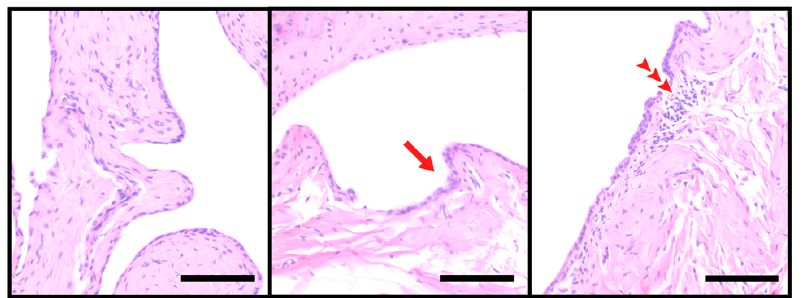
Figure 8. Representative images of synovitis in the PTOA group. Histological images of the synovitis, as demonstrated by surface fibrin and sub-synovial infiltration, found in the PTOA animals. Healthy synovium (first box) is presented as a comparison and represents Naive tissue. Surface fibrin (red arrow) and sub-synovial infiltration (red arrowheads) were found significantly more in the PTOA group compared to the Naive, but was not different between genetic variants. Images take at 20× magnification, scale bars represent 100 µm (N = 15 rats/PTOA group and N = 9 rats/Naive group).